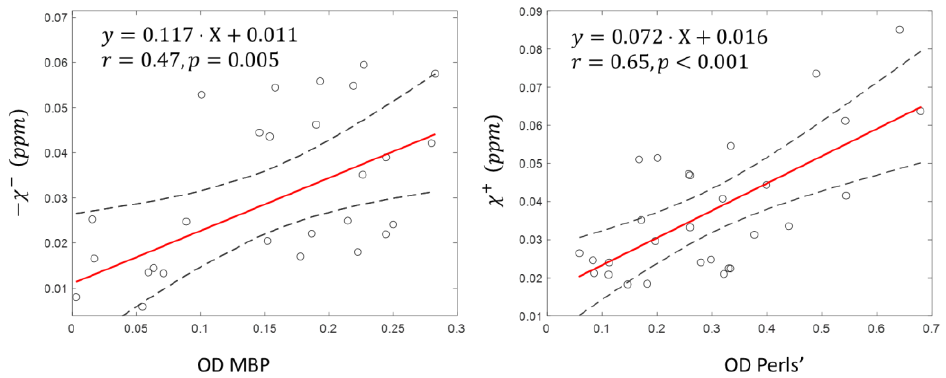
Figure 3. Correlation analysis between the average lesion/NAWM ROI source susceptibility and corresponding optical density of the histological stains. corresponding optical density of the histological